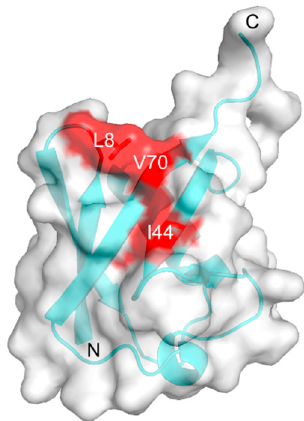
Figure 1. Crystal structure of ubiquitin (Ub; PDB: 1UBQ) [26] highlighting Leu8, Ile44, and Val70 on the hydrophobic surface with a transparent surface model presentation.